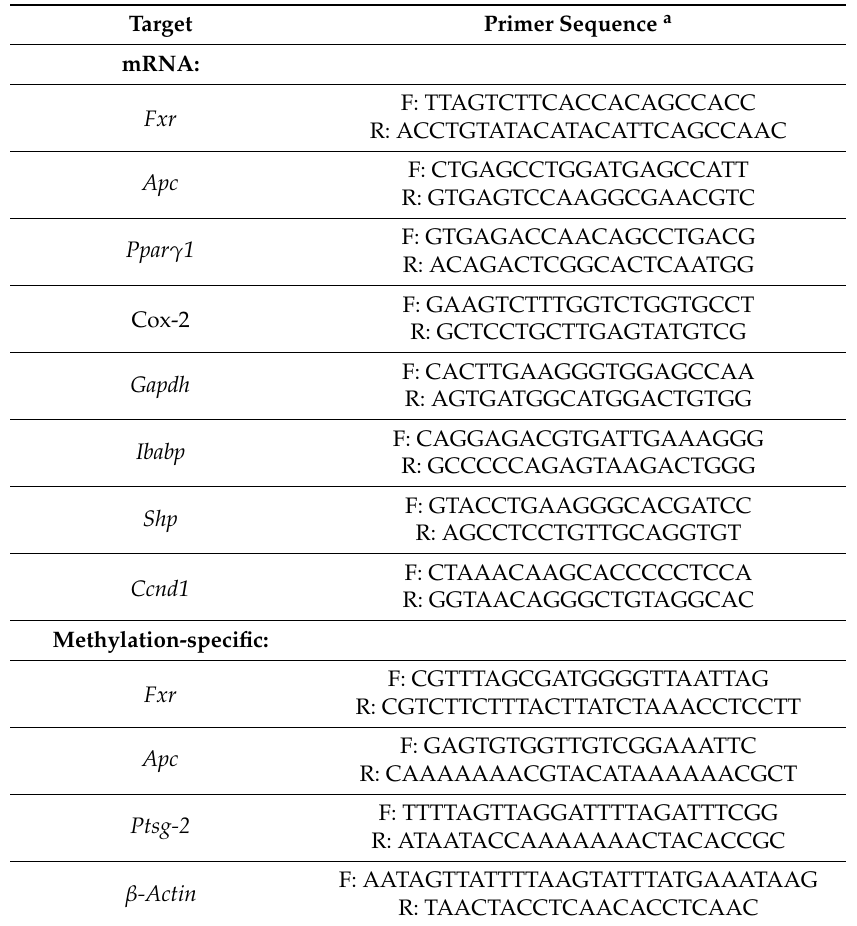
Table 2. The primers for RT-PCR and CpG methylation mouse